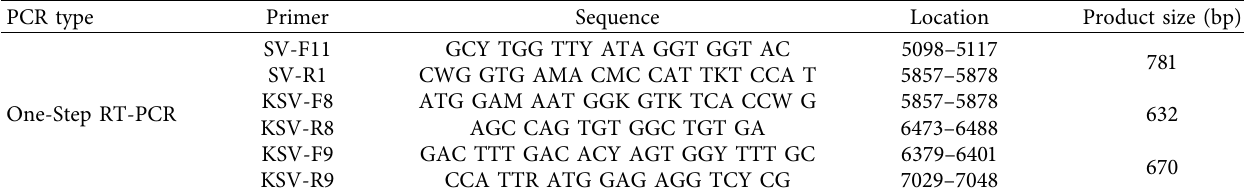
Table 1: Primers for amplification of VP1 segments